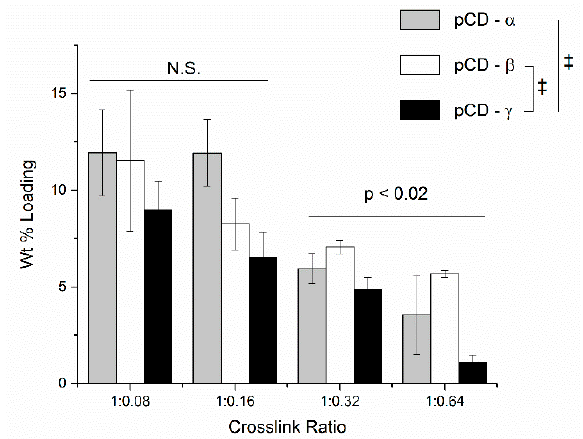
Figure 4. Minocycline loading decreased with increasing pCD crosslinking ratio. Briefly, minocycline ( MNC) (20 mg/mL) was loaded into polymerized cyclodextrin (pCD) for three days prior to washing, drying, and leaching extensively into water. MNC was quantified by UV/Vis. Although 1:0.08 was not significantly different than 1:0.16, 1:0.16 showed more loading than 1:0.32, which showed more loading than 1:0.64. MNC loading to pCD- α was similar to pCD- β ( p = 0.95) but was significantly different than pCD- γ ( p < 0.001 and = 0.001, respectively). Data shown is average ± std deviation for n = 3. N.S. Not significant; ‡ p ≤ 0.001.